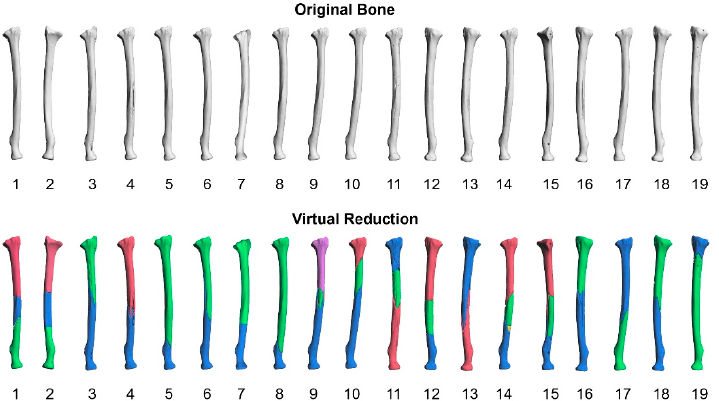
Figure 4. The original shapes of the 19 ORTHObones (top line) and the virtually reduced objects for all ORTHObones. The bone fragments in the virtually reduced object are represented by different colors (bottom line).